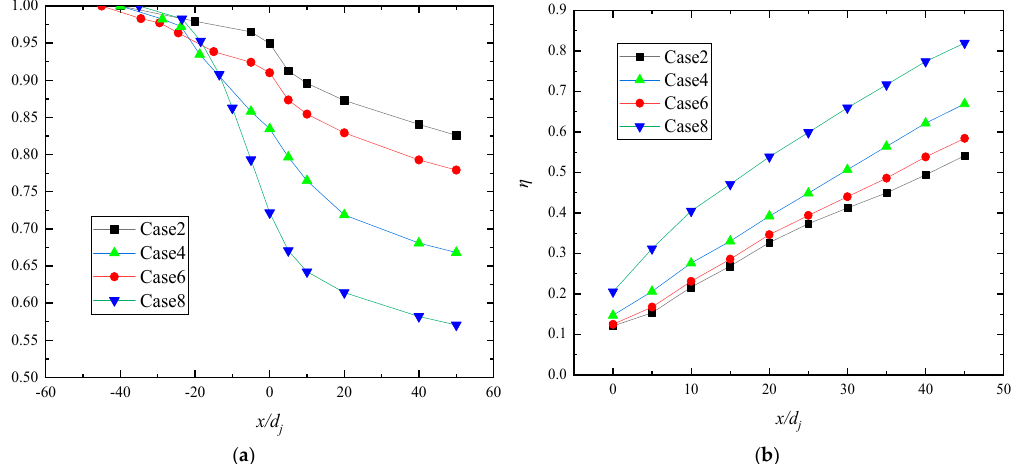
Figure 16. Comparison of mixing parameters along the flow direction of Case2, Case4, Case6, and Case8. ( a ) Total pressure recovery coefficient. ( b ) Mixing The influence of the shock wave interacting position on the mixing augmentation is in Figure 17. The difference in total pressure recovery coefficients of Case3, Case9, and Case10 are small in terms of total pressure loss. The shock wave interacting position af- fects the fuel counter-flow jet mixing in terms of mixing efficiency. After the fuel injection orifice, the mixing efficiency of Case9 is significantly higher than that of Case3 and 10. At x/d j = 40, Case9 improves by 16.8% compared with Case3 and 10. The oblique shock wave acts on the front of the jet, influencing the mixing efficiency.